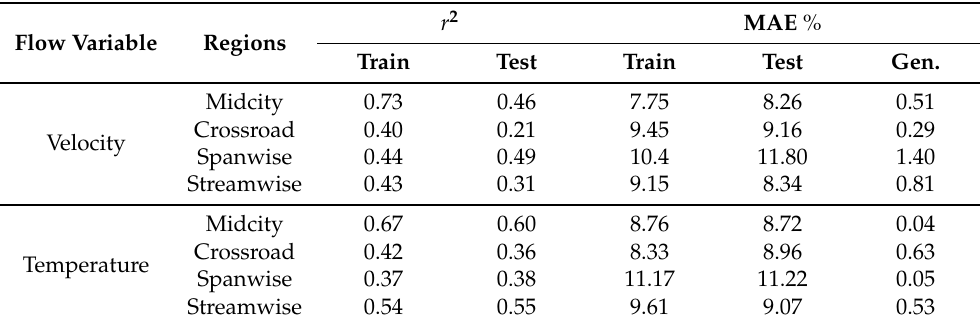
Table 6. Linear regression prediction results for velocity and